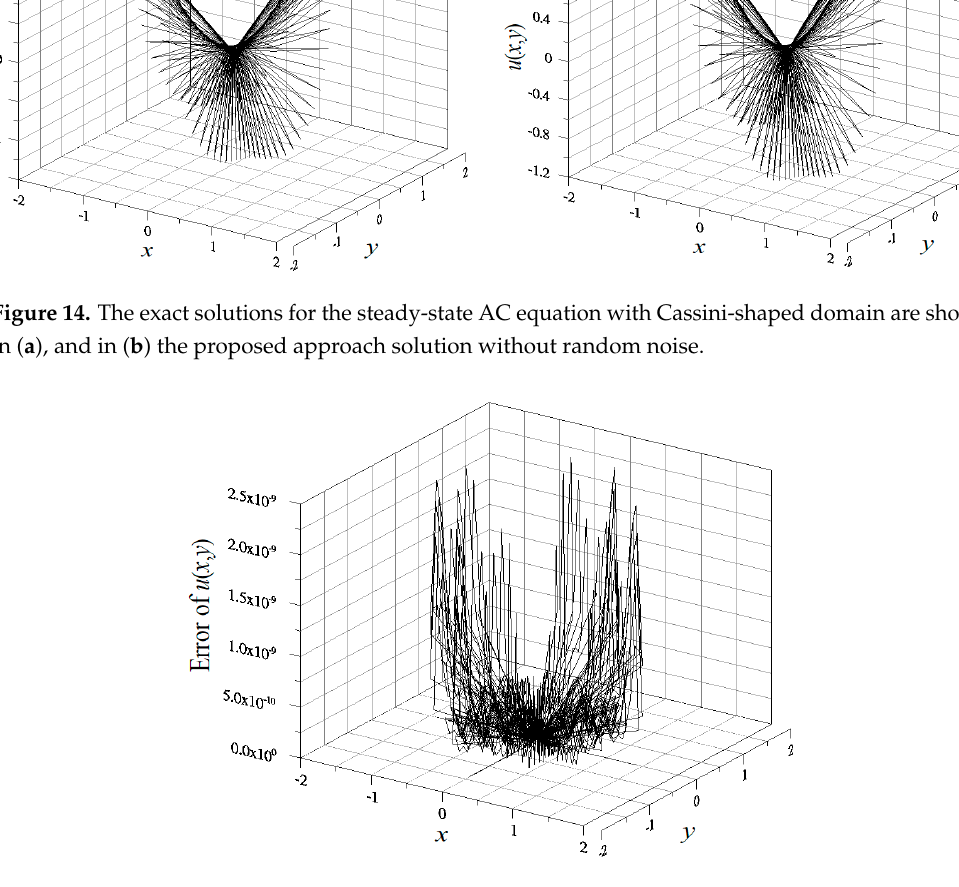
Figure 15. The numerical errors of proposed approach solution for the steady-state AC equation with a Cassini-shaped domain.